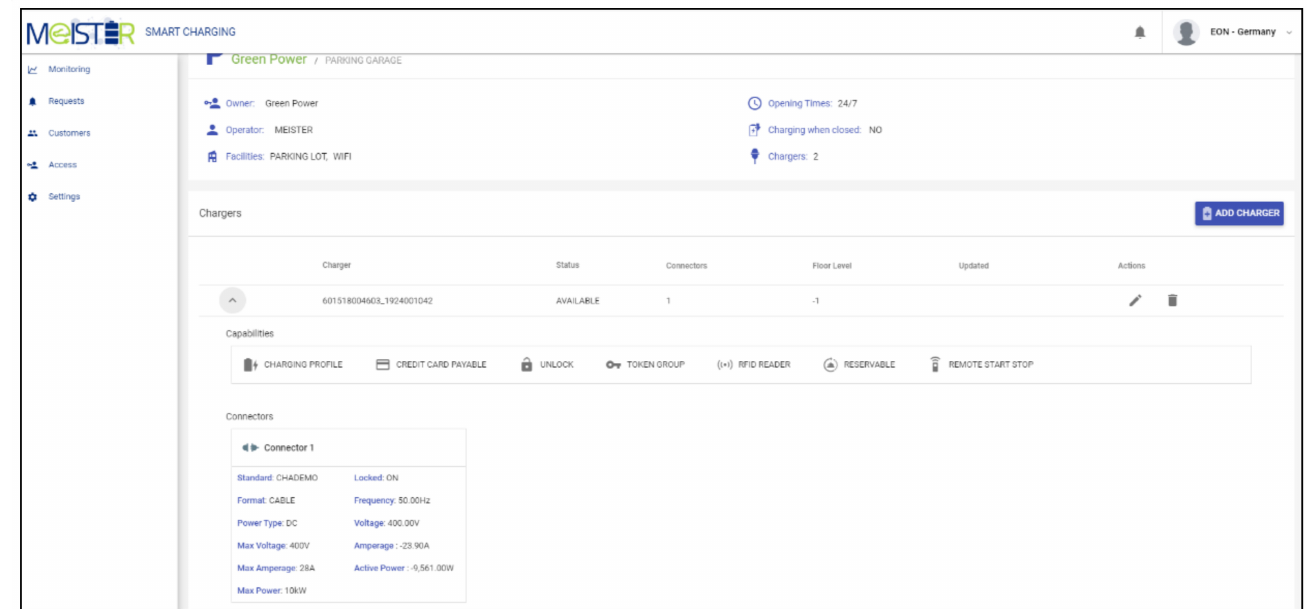
Figure 14. UC high load reduction “MAXPRED”, AME charger monitoring.